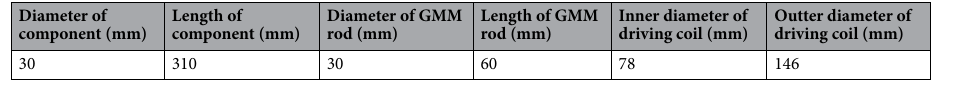
Table 1. Design parameters of GMM smart component.